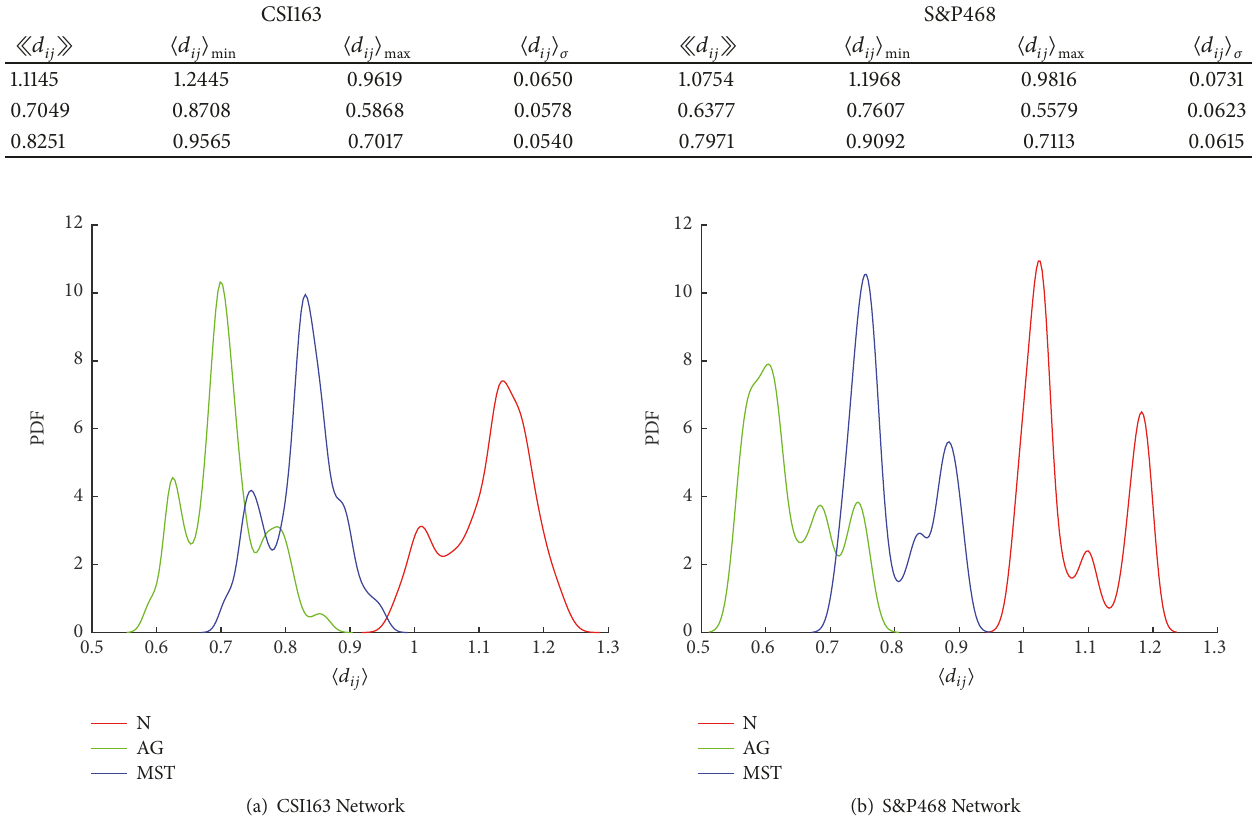
Figure 25: Probability density function (PDF) of average distance ⟨𝑑 𝑖𝑗 ⟩ of original network 𝑁 , asset graph 𝐴𝐺 , and minimum spanning tree 𝑀𝑆𝑇 for CSI163 and